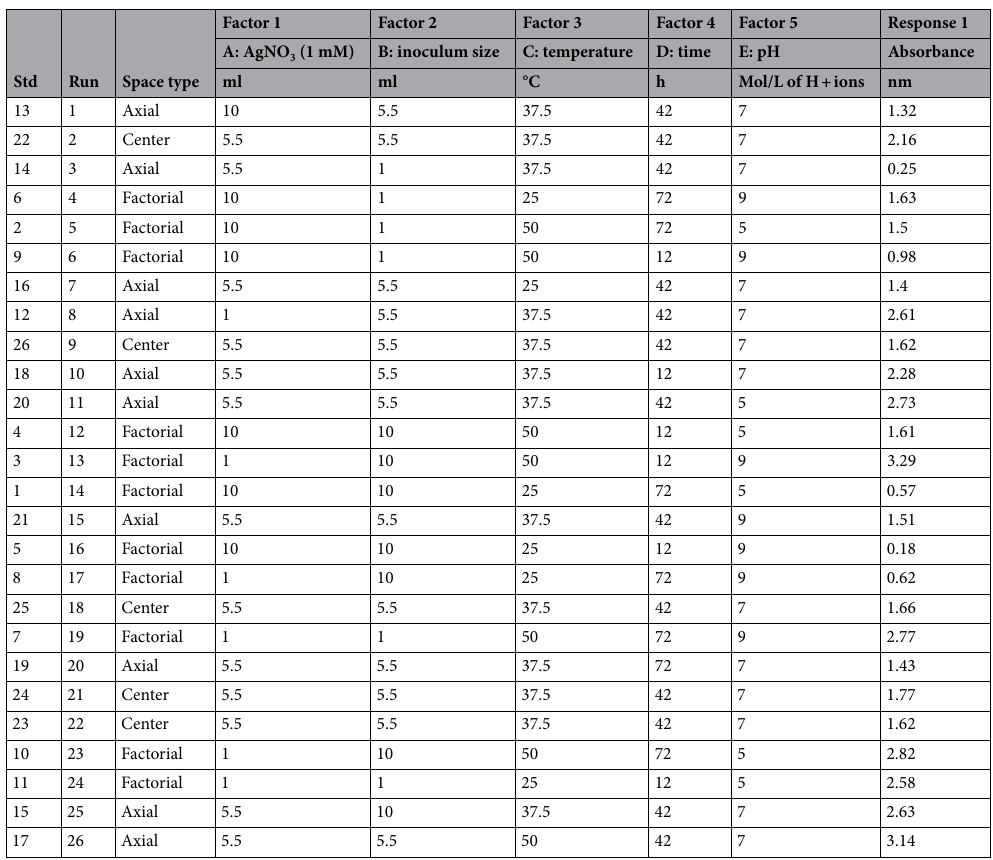
Table 2. The central composite design for the experiment.